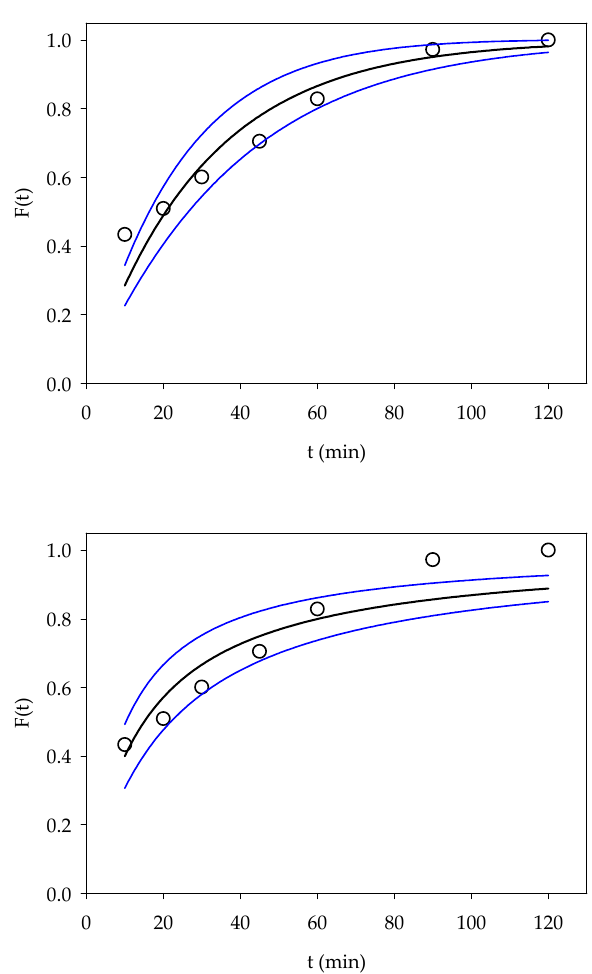
Figure 5. ( a ) Pseudo-first-order and ( b ) pseudo-second-order fitting of the fractional adsorption F(t) = q t / q e (empty circles) data. Lines: calculated data (black), 95% confidence interval (blue). Table 1. Pseudo-first-order and pseudo-second-order kinetic parameters K 1 (min − 1 ) and K 2 (g mg − 1 min − 1 ) for cisplatin sorption on Si-DTC at 25 °C.